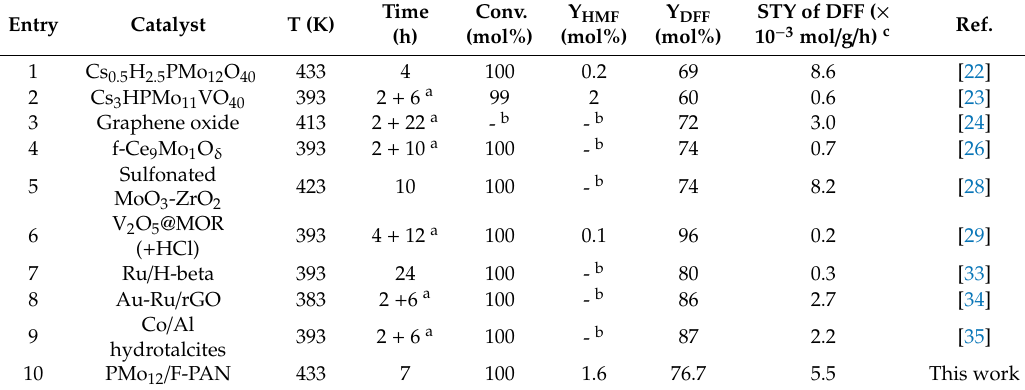
a The respective reaction time applied for the fructose-to-HMF dehydration under nitrogen atmosphere and the subsequent HMF-to-DFF oxidation under oxygen atmosphere. b Not mentioned in literatures. c The site time yield of DFF (mol of DFF / g of catalyst /